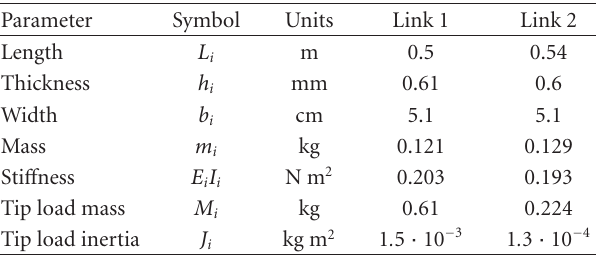
Table 1: Parameters of the flexible manipulator